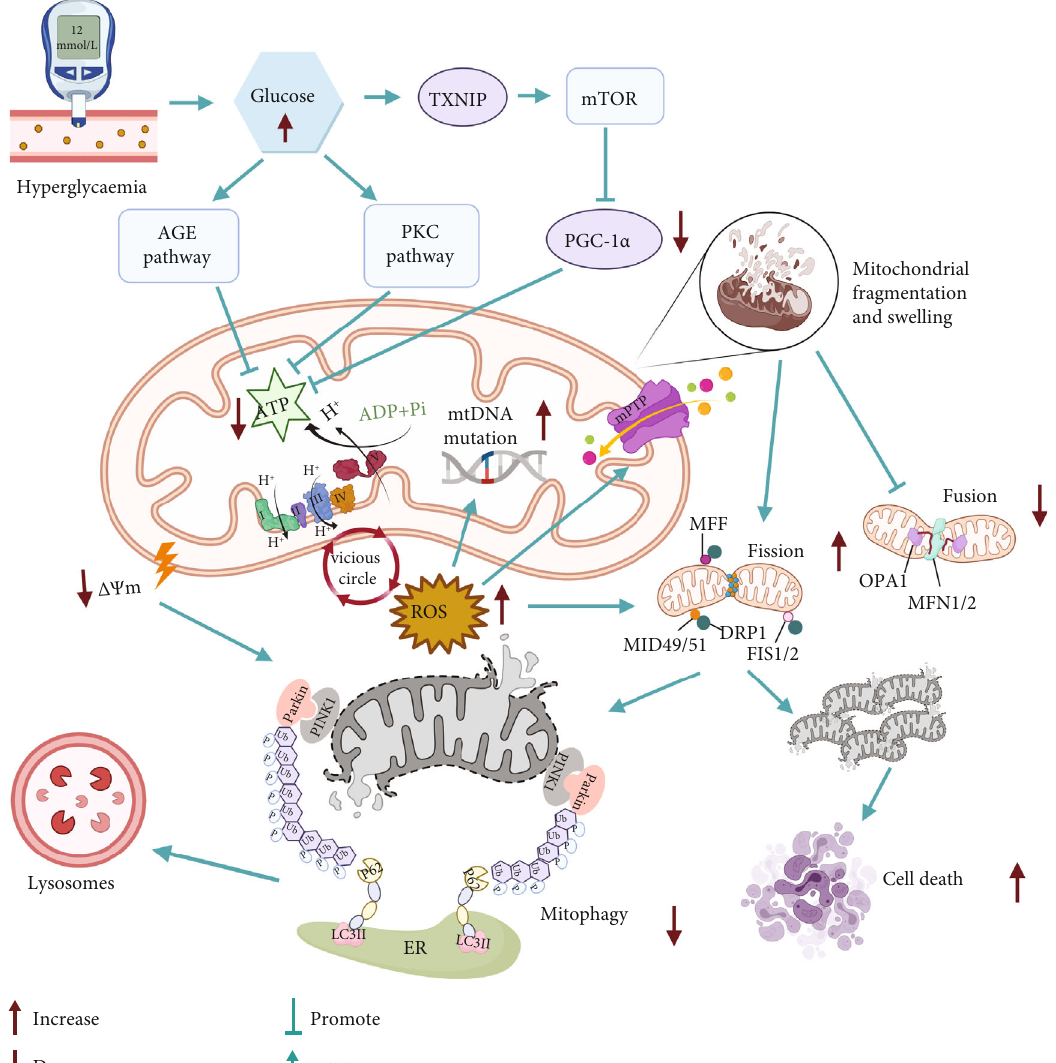
Figure 1: Hyperglycemia serves as the primary factor that in fl uences mitochondrial dysfunction in DN. The increased level of glucose enhances glycolysis, and the subsequent activation of the TXNIP, AGE, and PKC pathways reinforces the decrease in ATP levels. Insu ffi cient ATP levels stimulate the ETC to overwork in response to the energy supply for the kidneys. In turn, excessive ROS production occurs following the overactivation of the ETC, which results in decreased ATP production, mutation of mtDNA, abnormal opening of the mitochondrial permeability transition pore, and ultimately mitochondrial fragmentation and swelling. Decreases in the levels of OPA1, MFN1, and MFN2 may contribute to the decrease in mitochondrial fusion observed in DN. Activation of DRP1 promotes mitochondrial fragmentation and fi ssion. Damaged mitochondria are cleared by mitophagy. However, an excess number of damaged mitochondria that is higher than the rate of mitophagy may result in cell death. Abbreviations: DN: diabetic